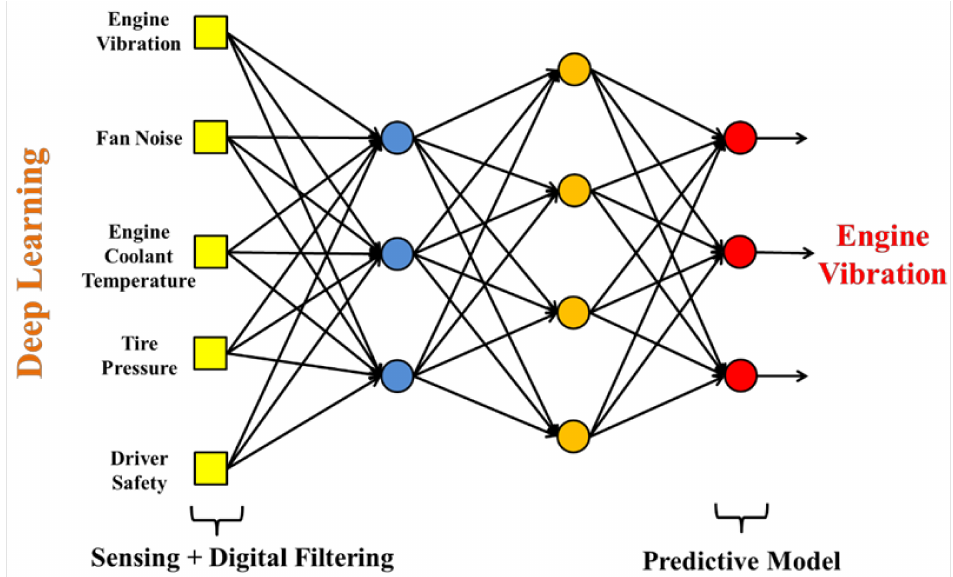
Figure 8. Multiple data source input